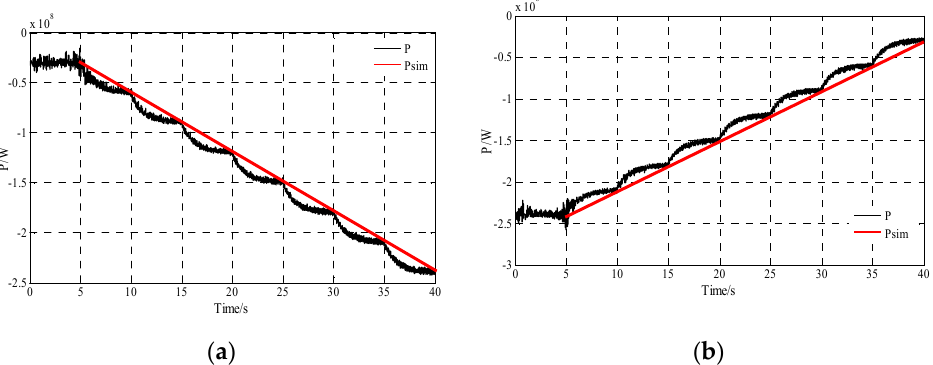
Figure 23. Comparison of active power waveform before and after equivalent. ( a ) load ramping stage; ( b ) load rejection stage.